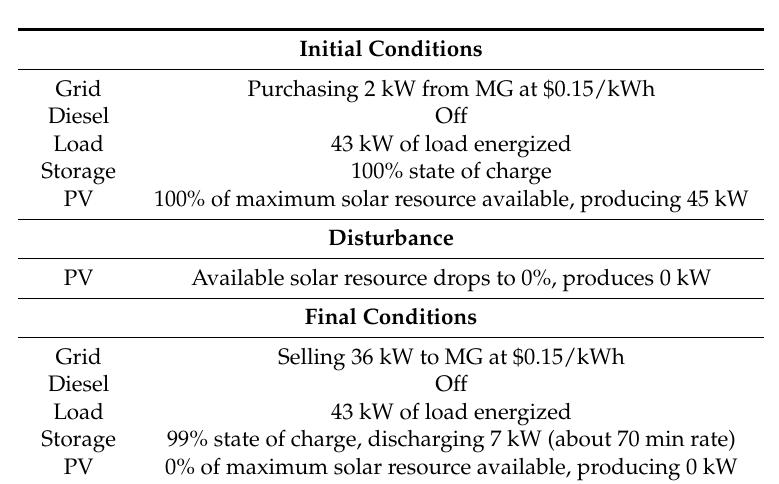
Figure 10. Storage producer agent cost ( top ) and performance ( bottom ) metrics after disturbance. Table 2. Scenario Parameters.